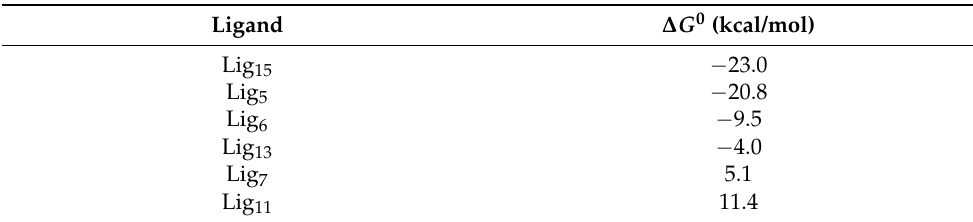
Table 2. Binding free energy estimates, ∆ G 0 , calculated using Equation (4) and (5). Calculation of ∆ G 0 was based on the last 30 ns of the